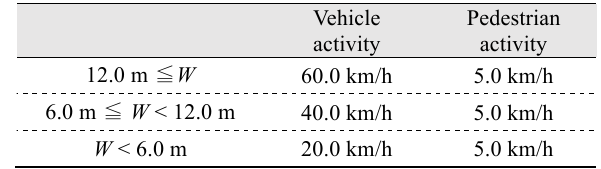
Table 5. Transportation speed on a street j, whose width is W m.